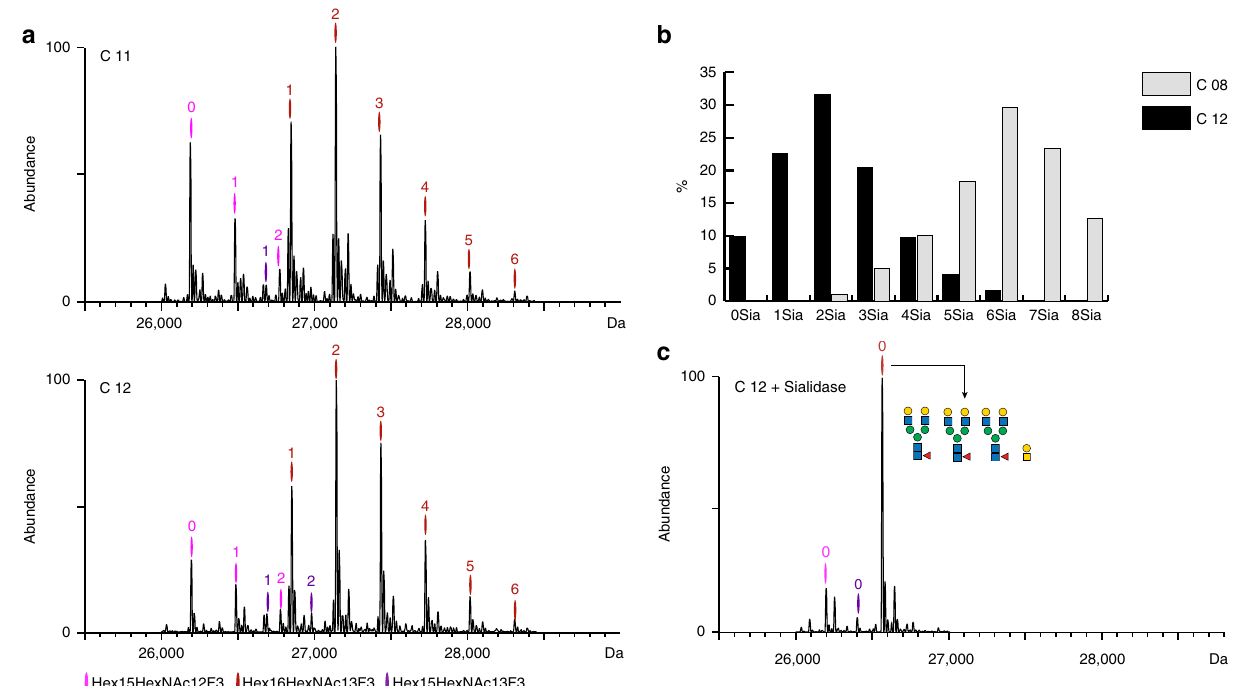
Fig. 3 Biological reproducibility and sialylation status of EPO clones expressing bi-antennary N -glycans. a Deconvoluted mass spectra of EPO from two biological replicate clones, C11 (top) and C12 (bottom) exhibiting variable degree of O-glycosite occupancy (Hex 15 HexNAc 12 F 3 glycoproteoform), b Comparison of sialylation on EPO puri fi ed from clone C08 ( mgat4A/4B/5 KO) and C12, whereby the latter has an additional st3gal4/6 KO. c Deconvoluted native mass spectrum of sialidase treated EPO puri fi ed from the C12 clone. The depicted glycan composition corresponds to the total glycan content of the most abundant mass peak. Main glycoproteoforms are color coded, wherein each color corresponds to a unique Hex x + 3 HexNAc x F 3 composition, and the numbers above the annotated peaks indicate the number of sialic acid